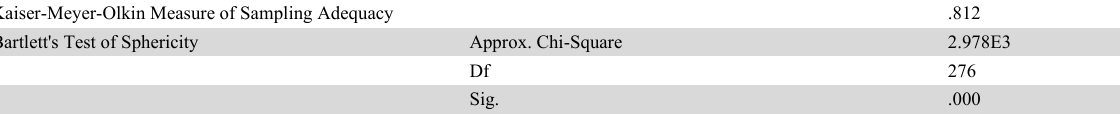
KMO and Bartlett's Test